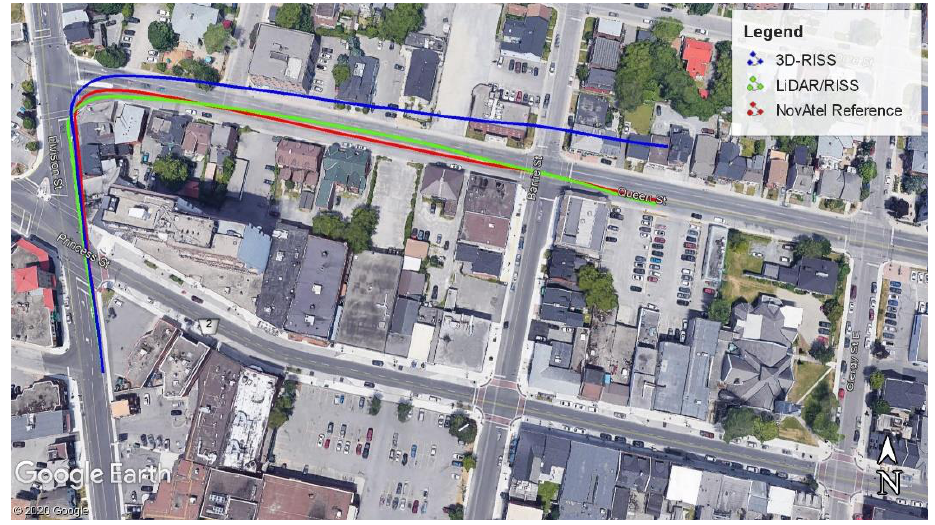
Figure 15. Navigation Solution for 3D-RISS, LiDAR / RISS, and NovAtel Reference during Simulated GNSS Outage 1, First